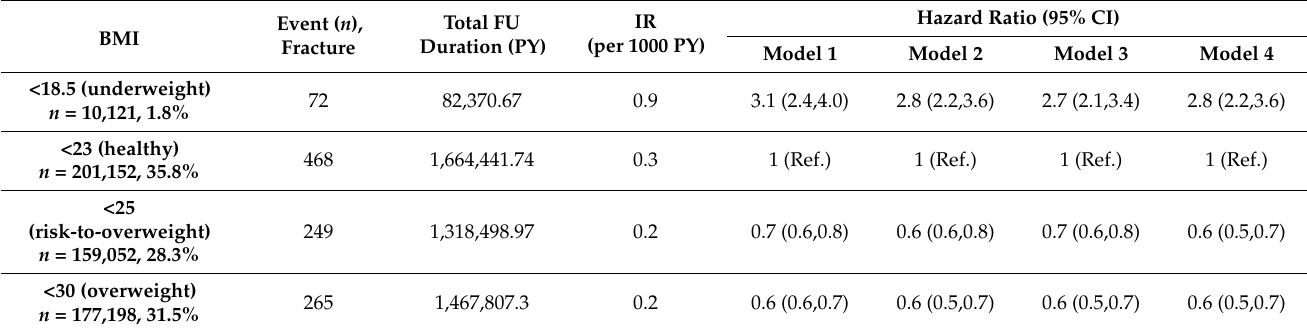
Table 2. The risk of hip fracture according to body mass